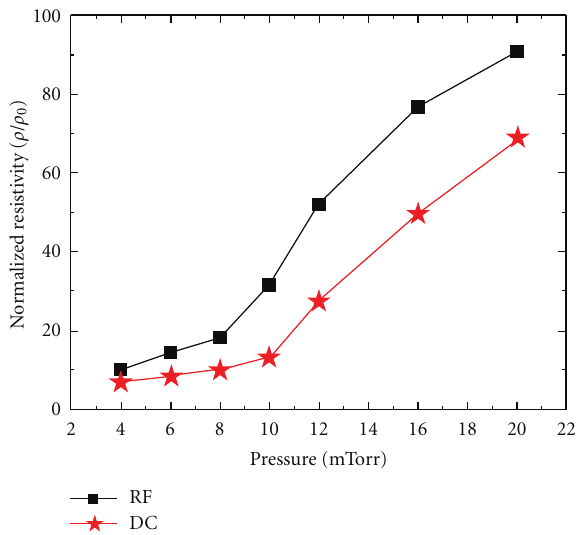
Figure 6: Normalized resistivity as a function of pressure for Mo thin films.